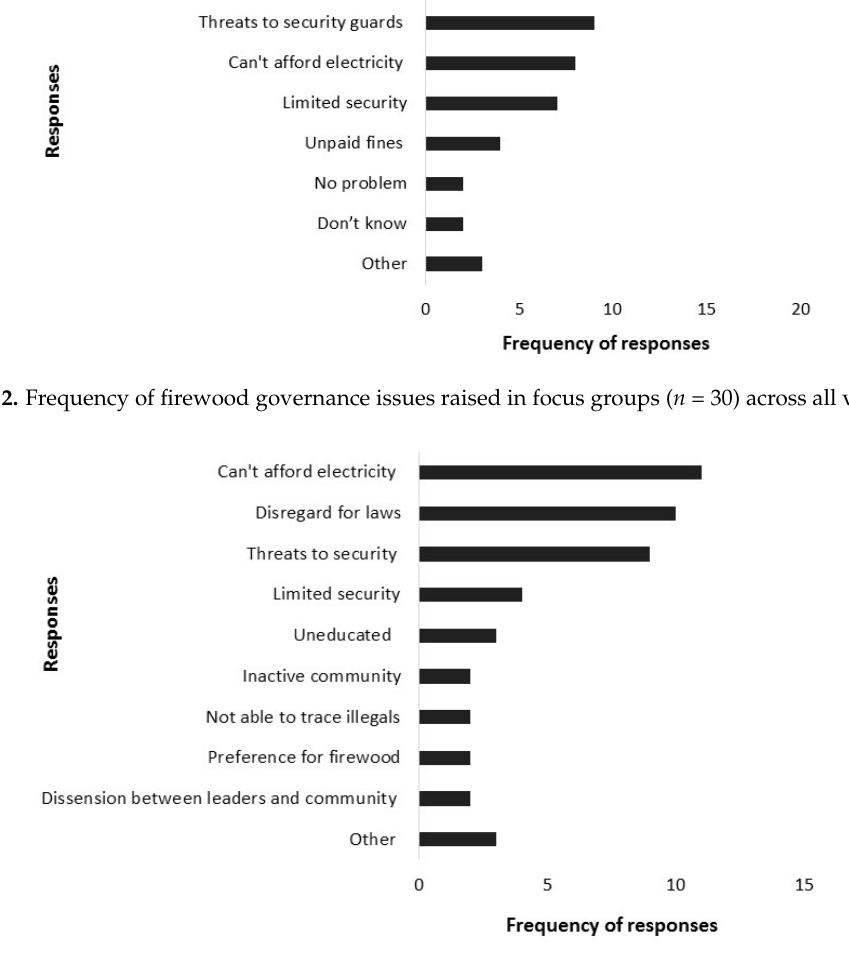
Figure 3. Frequency of firewood governance issues raised by leaders ( n = 30) across all villages.